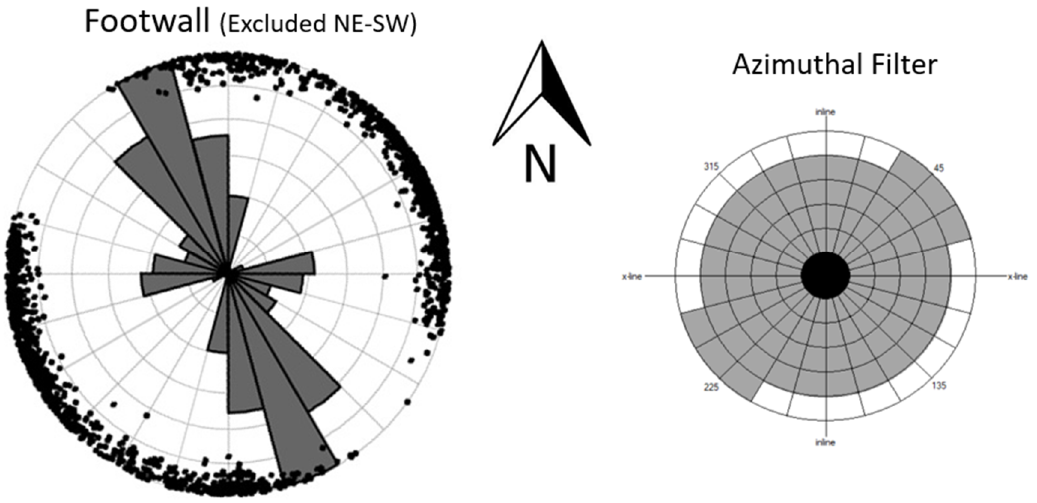
Figure 12. Rose diagram ( left ) after applying the azimuthal filter ( right ) to remove the dominant NE–SW striking orientation, forcing the artificial ants to detect fractures with secondary orientations.